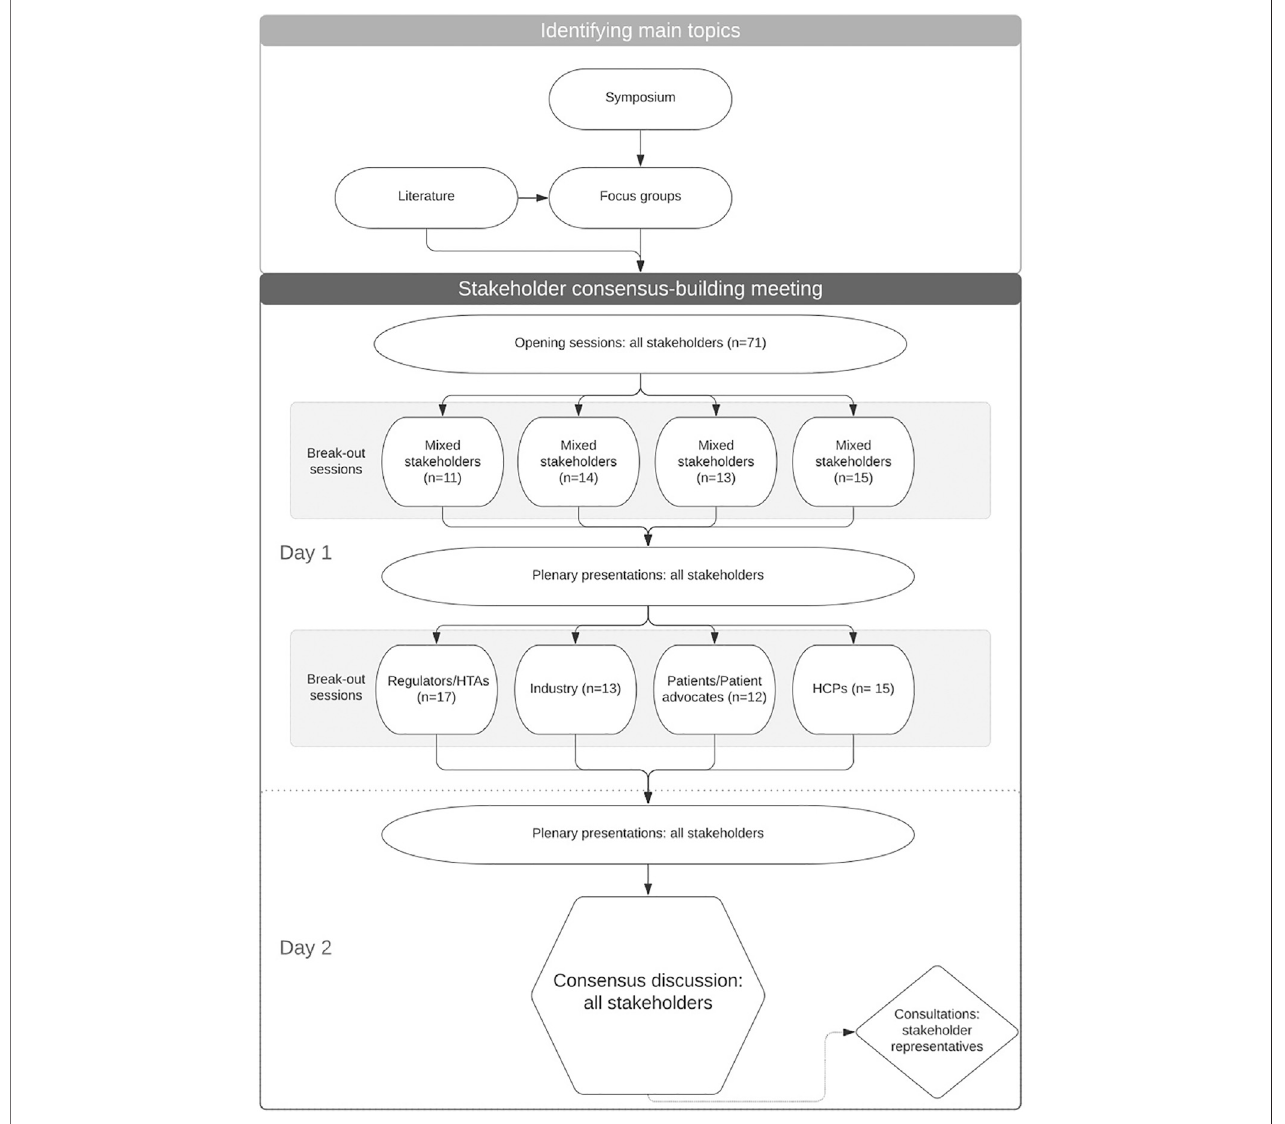
FIGURE 1 | Flowchart of the process of building consensus on a way forward to implementation of precision medicine in diabetic kidney disease during the consensus-building meeting inAmsterdam, April 2019. HTA, health technology assessors; HCPs, healthcare professionals( “ n ” equals the number of participants ofthe